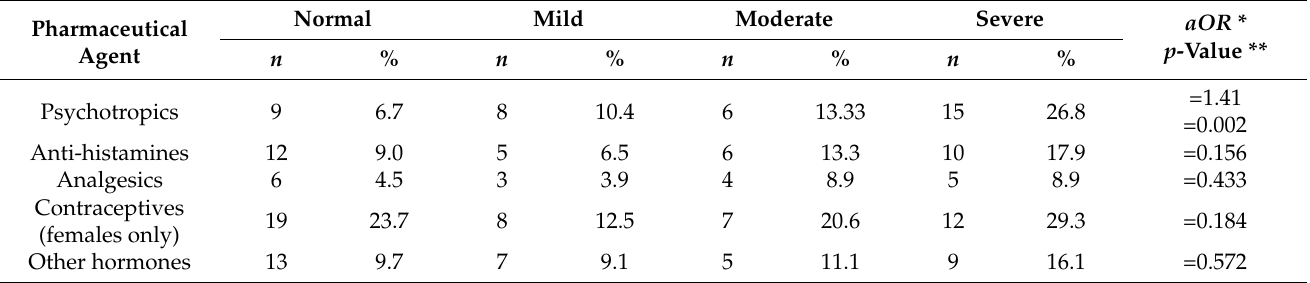
Table 5. Severity of dry eye, according to the OSDI, in the study participants by medication ( n =